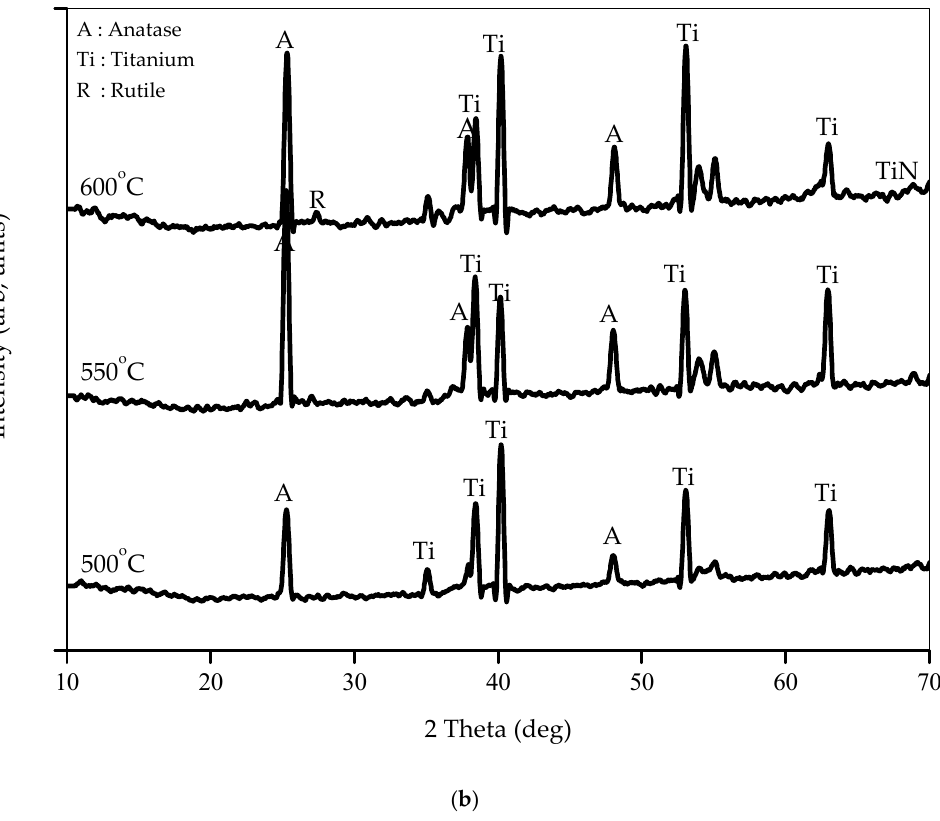
Figure 4. XRD patterns of ( a ) undoped and doped TiNTAs; ( b ) Ni-N-TiNTAs with various annealing temperatures.